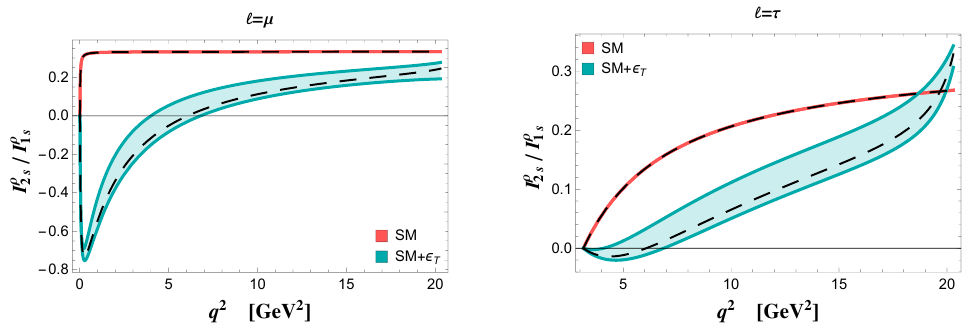
Figure 9. Ratio R ρ in (7) for ¯ B → ρ ( ππ ) µ − ¯ ν µ ( left ) and ¯ B → ρ ( ππ ) τ − ¯ ν µ ( right ). The dashed lines 2 s /1 s are the Large Energy result (extrapolated to the full q 2 range).